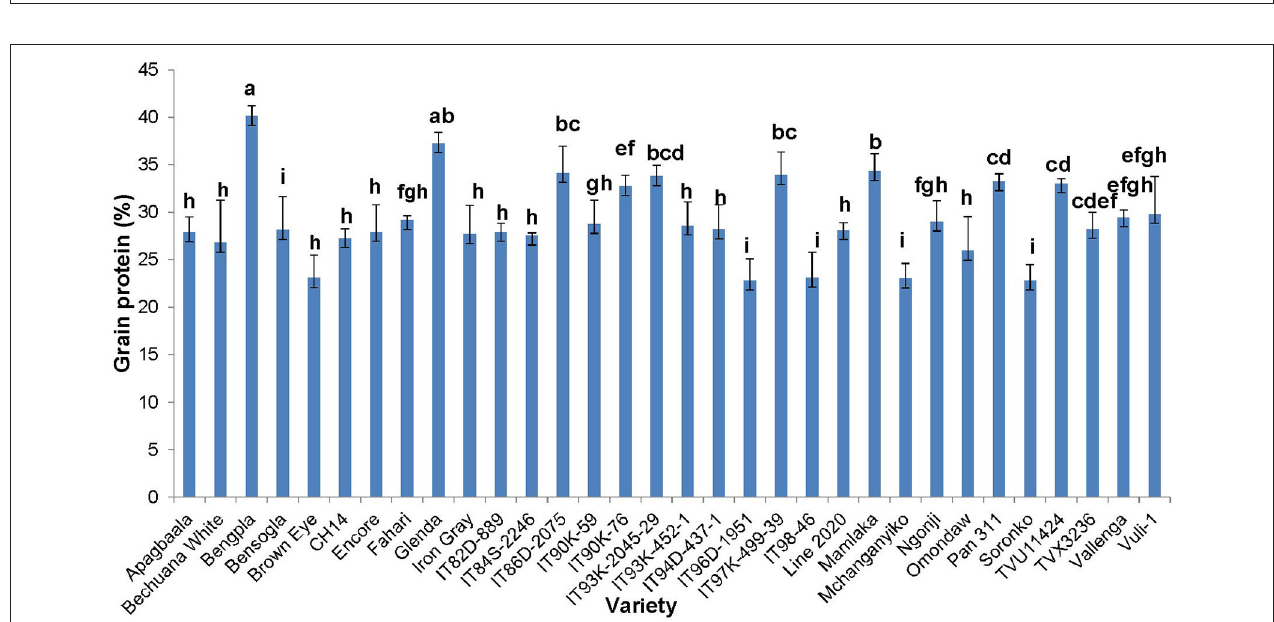
FIGURE 4 | Protein levels in edible seed of 32 cowpea genotypes grown in the field at Taung, South African (dotted line in red denotes 30% or more